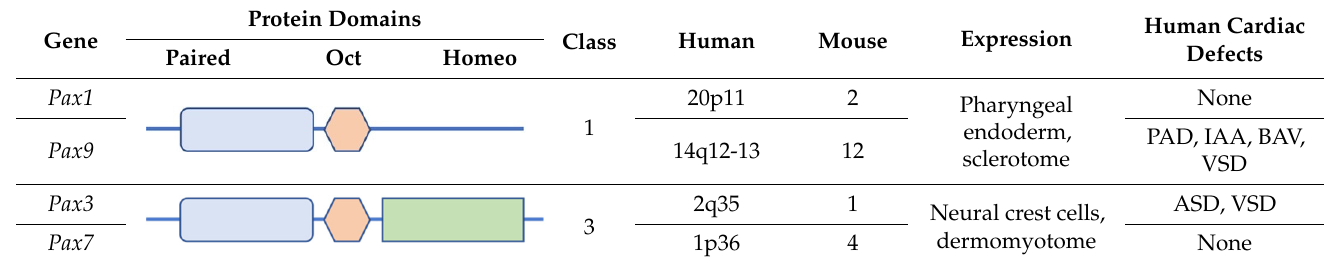
Table 1. Structure and expression of Pax genes discussed in this review.